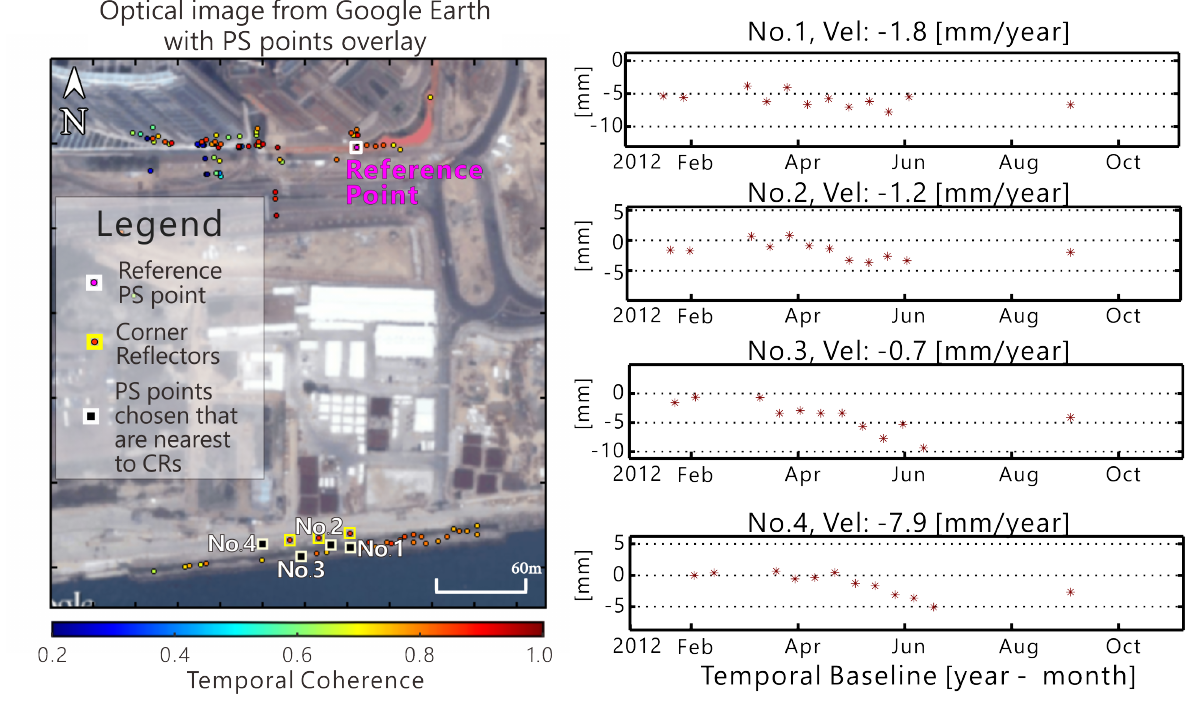
Figure 13. Here, we selected four PS points that were closest to each of the four CRs. The time series analysis of the four PS points shows a moving trend. In this case, since the vertical displacements were biased, this moving trend is very likely to be an eastward horizontal